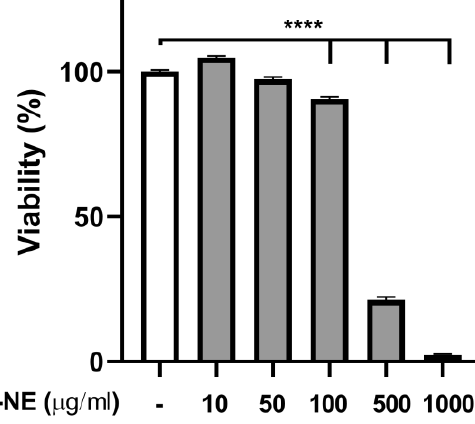
Figure 1. Effect of Agarwood-NE on the cell viability of 5% CSE-induced BCi-NS1.1 cells. BCi-NS1.1 cells were pre-incubated for 1 h in the presence of increasing concentrations of agarwood-NE (10, 50, 100, 500, or 1000 µg/mL), followed by exposure to 5% CSE for 24 h. Upon treatment, MTT assay was used to measure cell viability. Cell viability was normalised as a percentage compared to untreated control. The results are mean ± SEM of 3 independent experiments (****; p < 0.0001).